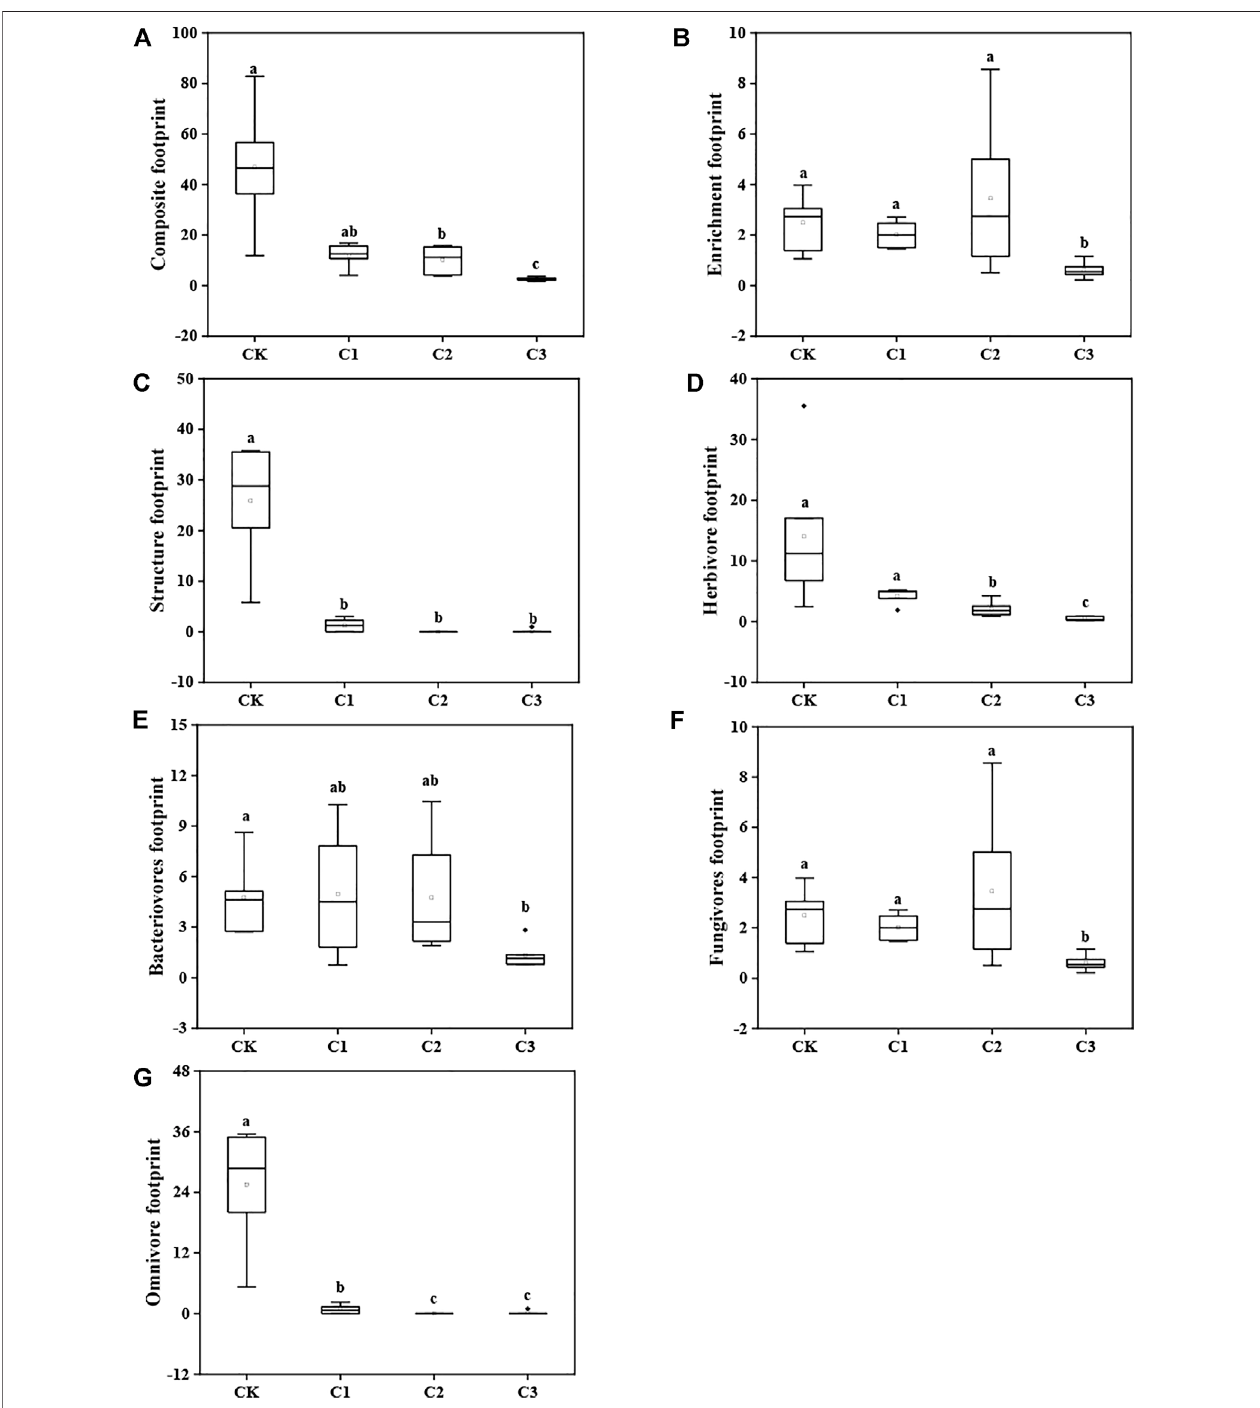
FIGURE 5 | Metabolic footprints of soil nematode assemblages exposed to varying magnitudes of microplastic pollution. The box-plot shows the min, lower quartile, median, mean, and upper quartile values, and the whiskers show the range of the variation. Different lowercase letters show a signi fi cant difference ( p < 0.05) acrosstreatments.CK:nomicroplasticsaddedtothesoil;C1:75 gofmicroplasticsaddedtothesoil(0.5%,w/w);C2:150 gofmicroplasticsaddedtothesoil(1%,w/w), and C3: 300 g of microplastics added to the soil (2%, w/w).